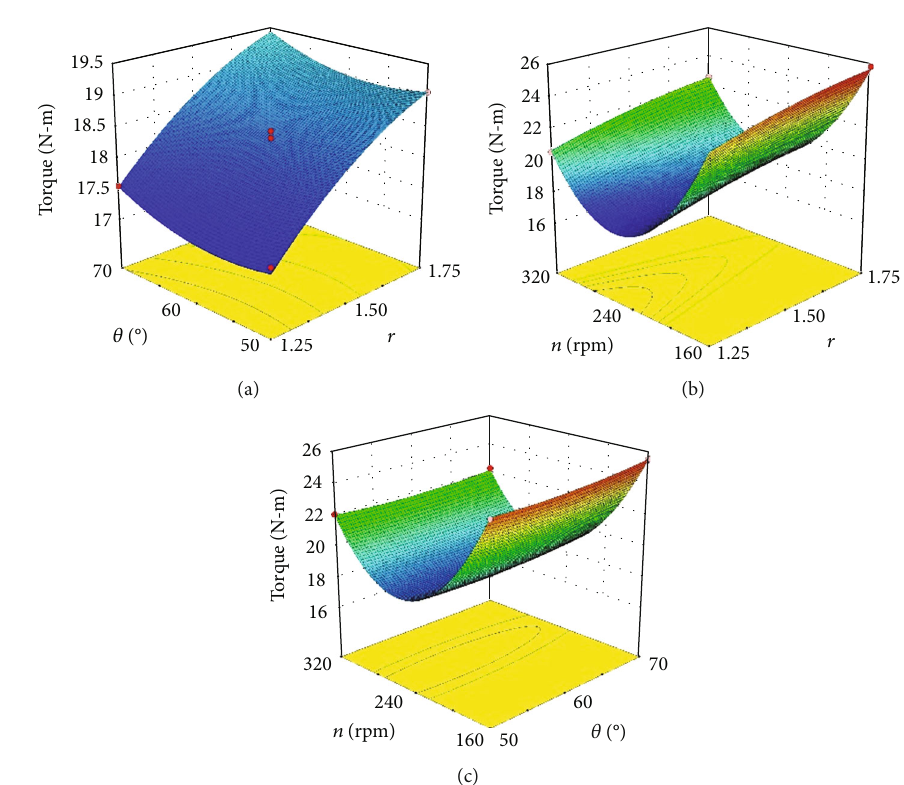
Figure 12: Response surface diagrams of torque: (a) n = 240 ; (b) θ = 60 ° ; (c) r = 1 : 50 .